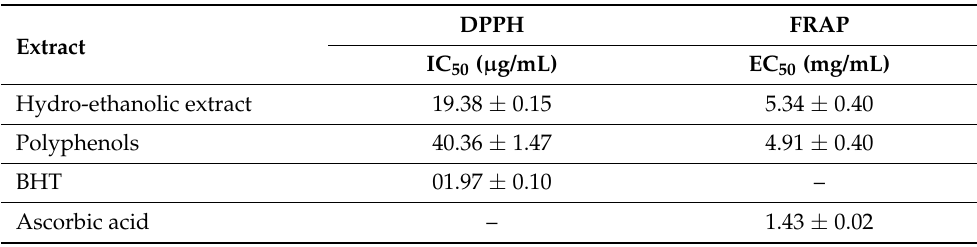
Figure 2. Antioxidant activity of the hydro-ethanolic and polyphenols extracts of P. sativum Hoffm. using DPPH ( a ) and FRAP ( b ) assays. Table 3. Antioxidant activity of hydro-ethanolic and polyphenols of P. sativum Hoffm. using DPPH and FRAP methods.